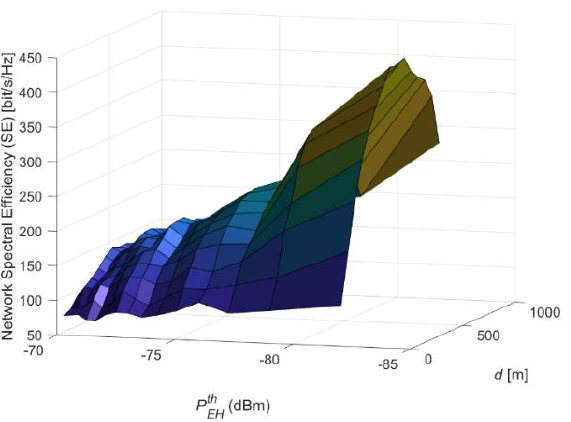
Figure 20. The relationship between the network SE, the maximum allowable D2D distance 𝑑 , and the predetermined EH threshold (i.e., 𝑃 𝐸𝐻𝑡ℎ ). Higher 𝑃 𝐸𝐻𝑡ℎ : moving toward non-EH-based D2D communications. Lower 𝑃 𝐸𝐻𝑡ℎ : moving toward EH-based D2D communications.